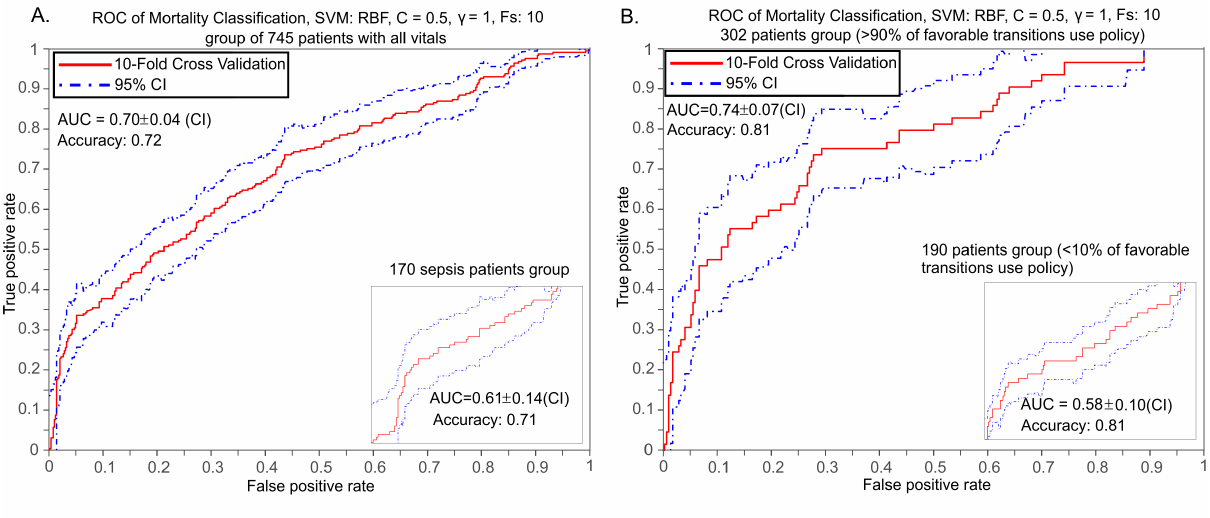
Figure 2. ROC curves of mortality classification/prediction. Support Vector Machine training results, given the provided vitals and mortality model, in a 10-fold cross validation scheme. The features used for the classification are temperature, respiratory rate, WBC, MAP and lactate levels and 745 patients for whom all seven variables were available were considered out of the 1492 of the DB. Radial Basis Function (RBF) kernel was used for the SVM training. The five measurement variables were summarized by their mean and standard deviation (STD) across the trajectory of each patient. Principal Component Analysis (PCA) was also used to assess whether linear transformation of the feature space and dimensionality reduction can be achieved in this case. A filter method was applied using the Area Under the Curve (AUC) of the Receiver Operating Characteristic (ROC) curves as a ranking criterion. The positive/negative classes for mortality prediction are defined as alive/deceased respectively. (A) Classification using the patients that have all features available. The maximum prediction accuracy when all patients with available all vitals are used, is 0.72 (72%) and the AUC is 0.70. (Inset) Classification using the 170 patients that have a diagnosis related to Sepsis. The maximum prediction accuracy is 0.71 (71%) and the AUC is 0.61. (B) SVM classification performance when the patient group that have ratio of transitions to better states with policy drugs vs all transitions to better states > 0.9 (302 patients out of 745) is used. (Inset) SVM classification performance for the patient group that have ratio of transition to